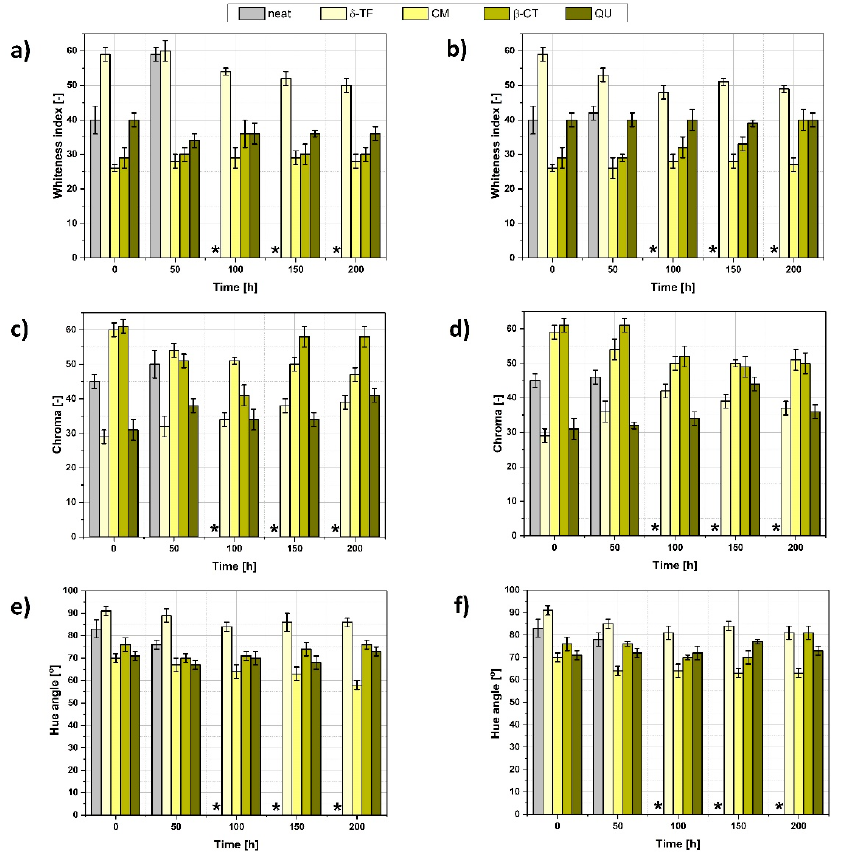
Figure 5. Additional parameters, namely, whiteness index, chroma, hue angle, contributing to color change of ENR/PLA blends and their variations during the thermo-oxidative (respectively: ( a , c , e )) and UV (respectively: ( b , d , f )) accelerated aging processes. *—sample too brittle to be examined with the selected method; the measurement was impossible.